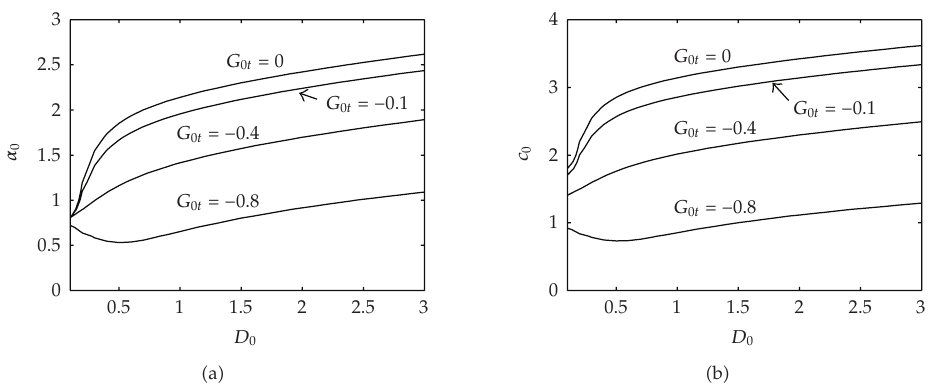
Figure 5: Variation of the linear neutral (cid:3) a (cid:4) wave number and (cid:3) b (cid:4) wave speed against the Damkohler number for increasing buoyancy